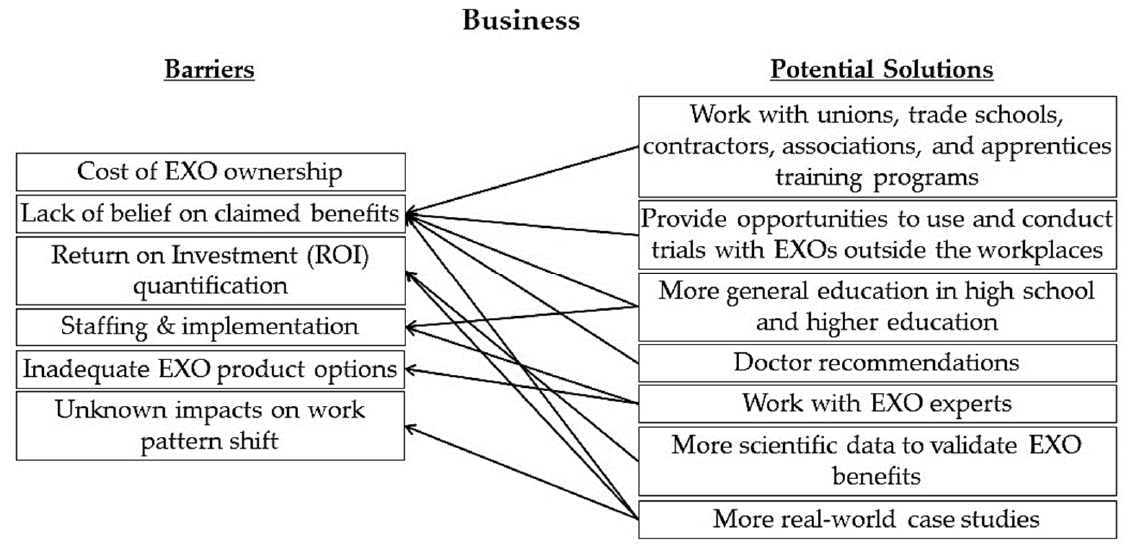
Figure 2. Mapping of potential solutions to identified barriers in the business category.